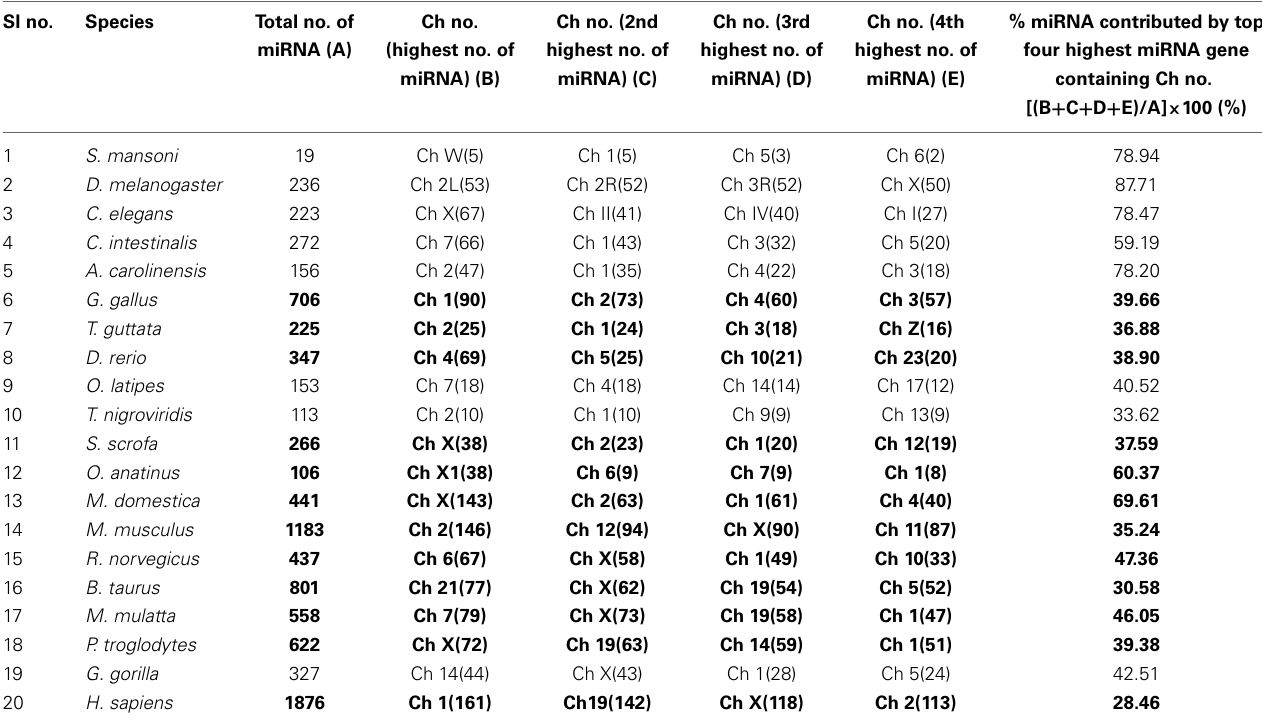
Table 1 | Percentage of miRNA gene counts in top four highest number of miRNA gene containing chromosomes. Sl